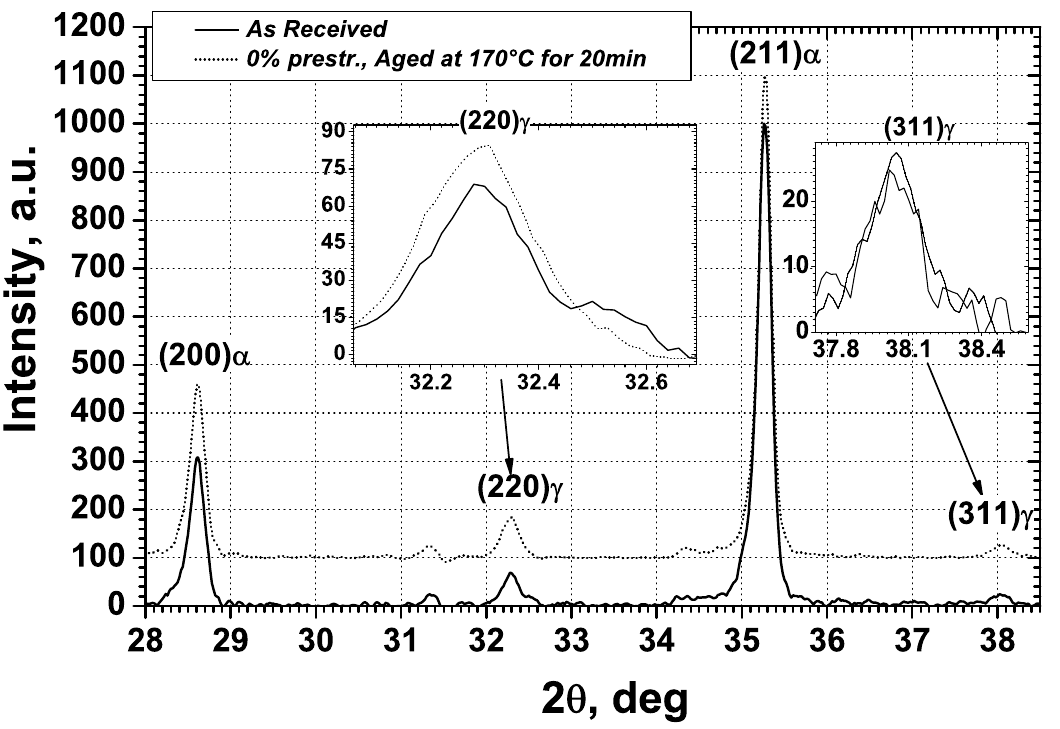
Figure 16. Evolution of the carbon content and volume fraction of retained austenite for the TRIP2 steel in the samples before and after aging at 170 ◦ C for 20